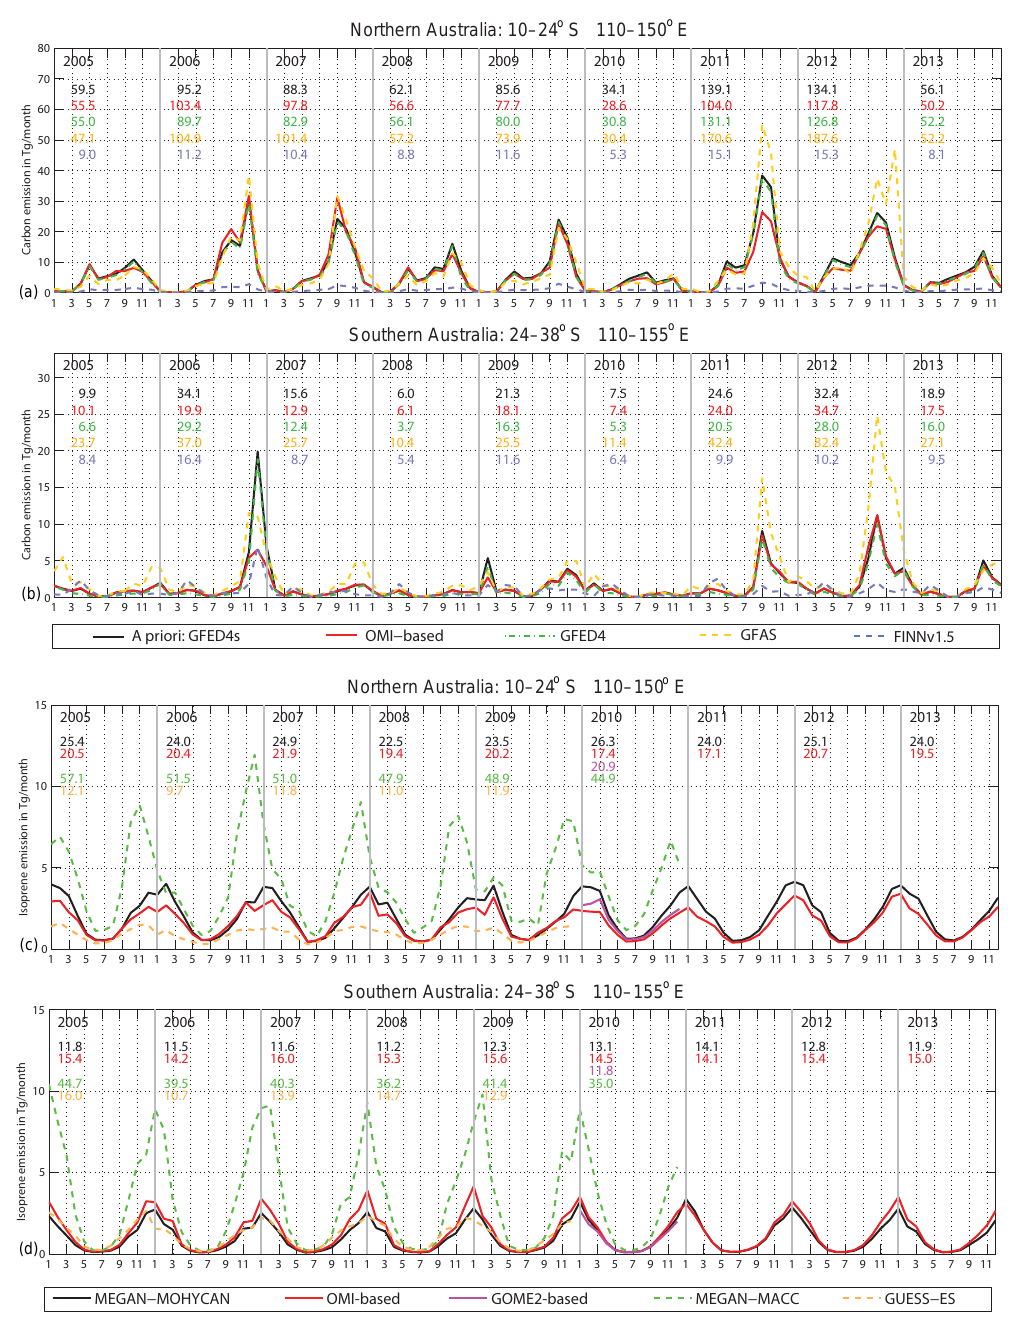
Figure 14. As Fig. 9 but for northern and southern